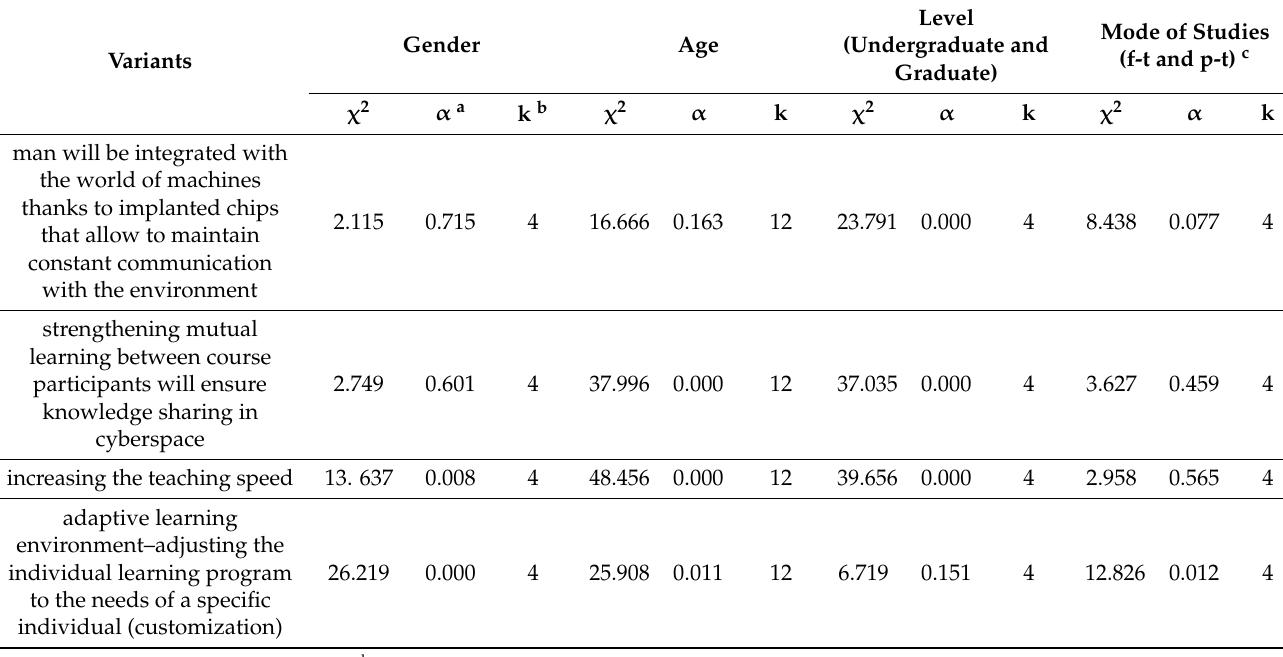
Table 5. Manifestations of Artificial Intelligence (AI) in the education of the future in terms of gender, age, level, and mode of study–test of independence χ 2